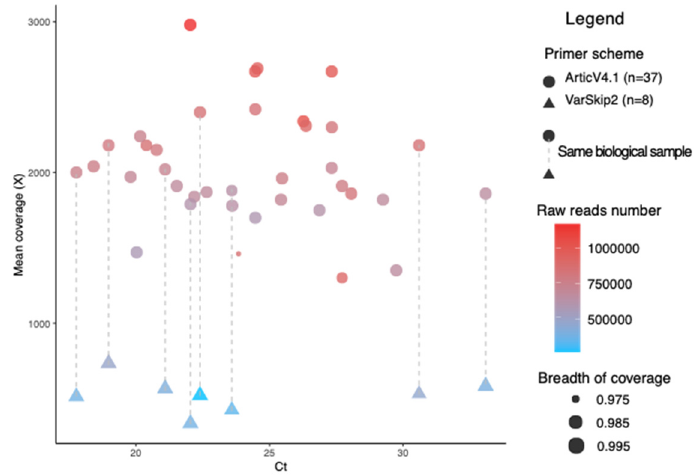
Figure 1. Sequencing outcomes of 37 clinical samples sequenced using the ArticV4.1 primer scheme with a subset of eight using VarSkip2. The X -axis shows samples’ Ct values, the Y -axis shows the mean coverage (X). Circles and triangles represent samples sequenced using ArticV4.1 and VarSkip2, respectively. The subset samples sequenced using both primer schemes ( n = 8) are indicated by the connection of gray dashed lines. Color scale shows paired end read numbers in each sample increasing from blue to red. Point sizes represent the breadth of coverage for each sample.